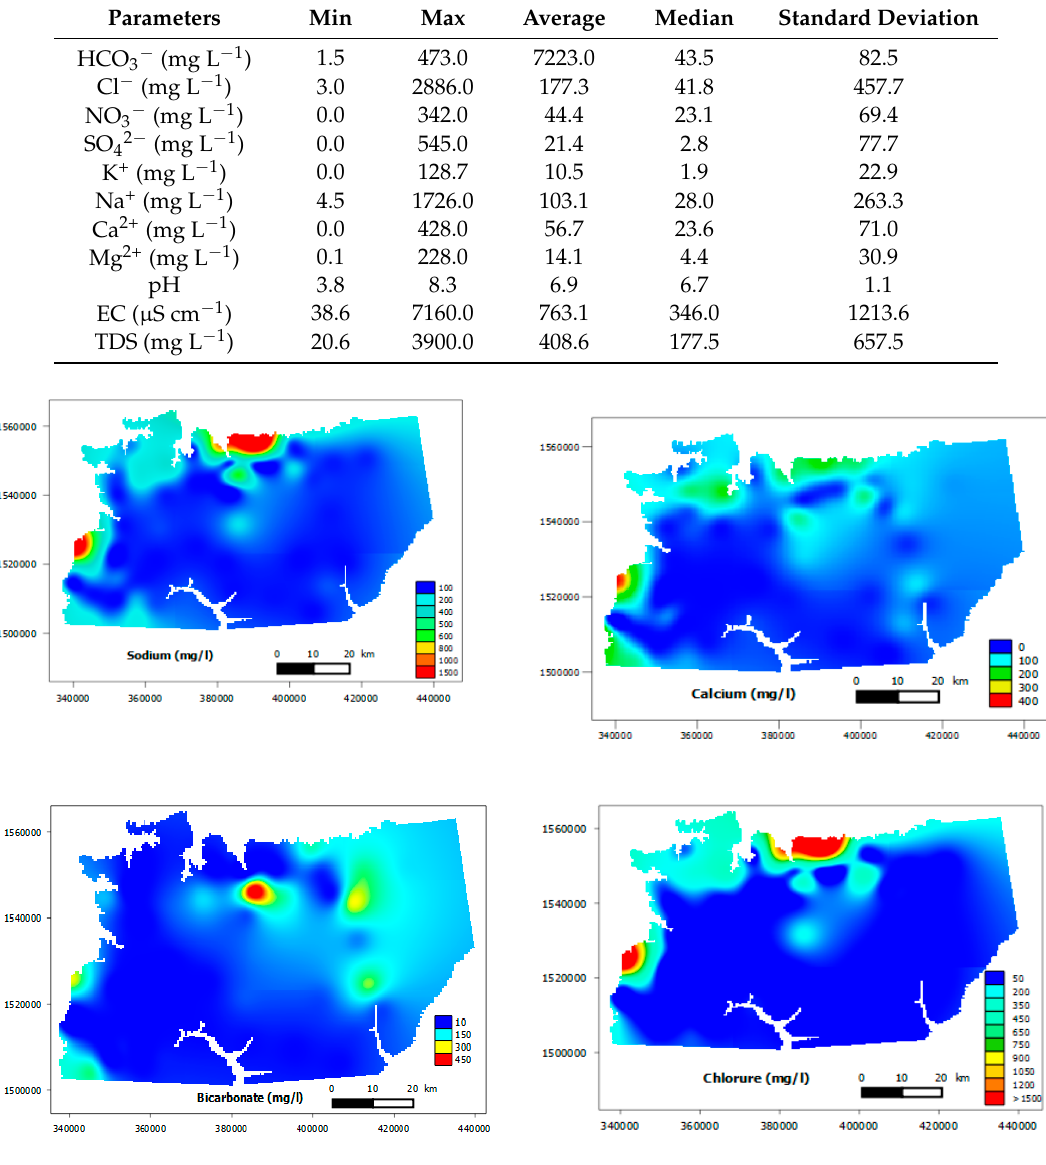
Table 2. Summary statistics for concentrations of chemical constituents.